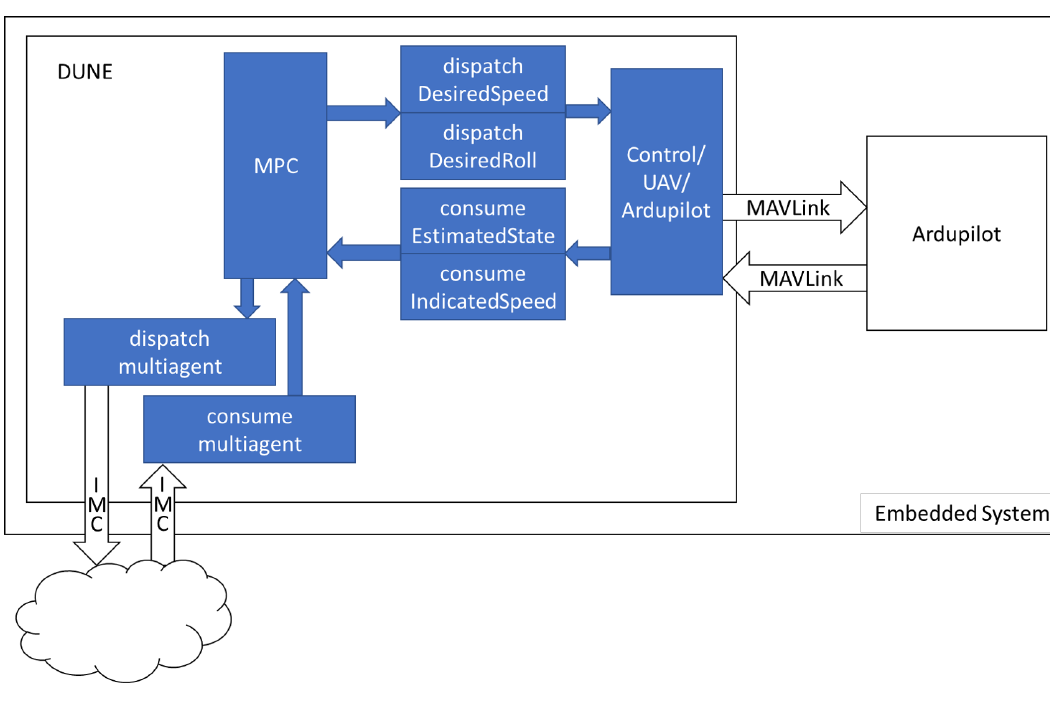
Figure 1. Simplified DUNE block